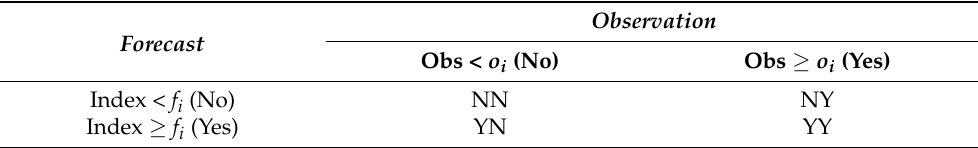
Table 1. A simple 2 × 2 contingency table, expressing the joint occurrence of a turbulence index greater than or less than some threshold value f i and an observation greater or less than threshold value o i